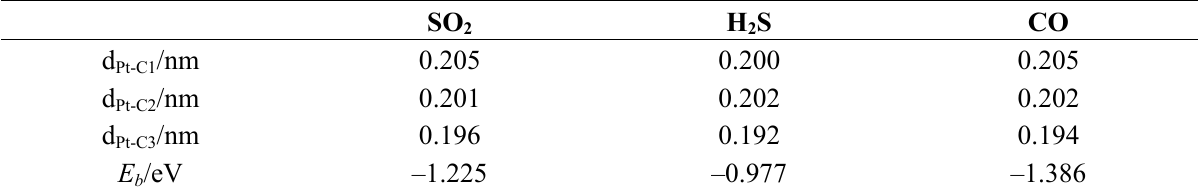
Table 1. Adsorption energy and structural parameters of Pt-SWCNTs adsorption.